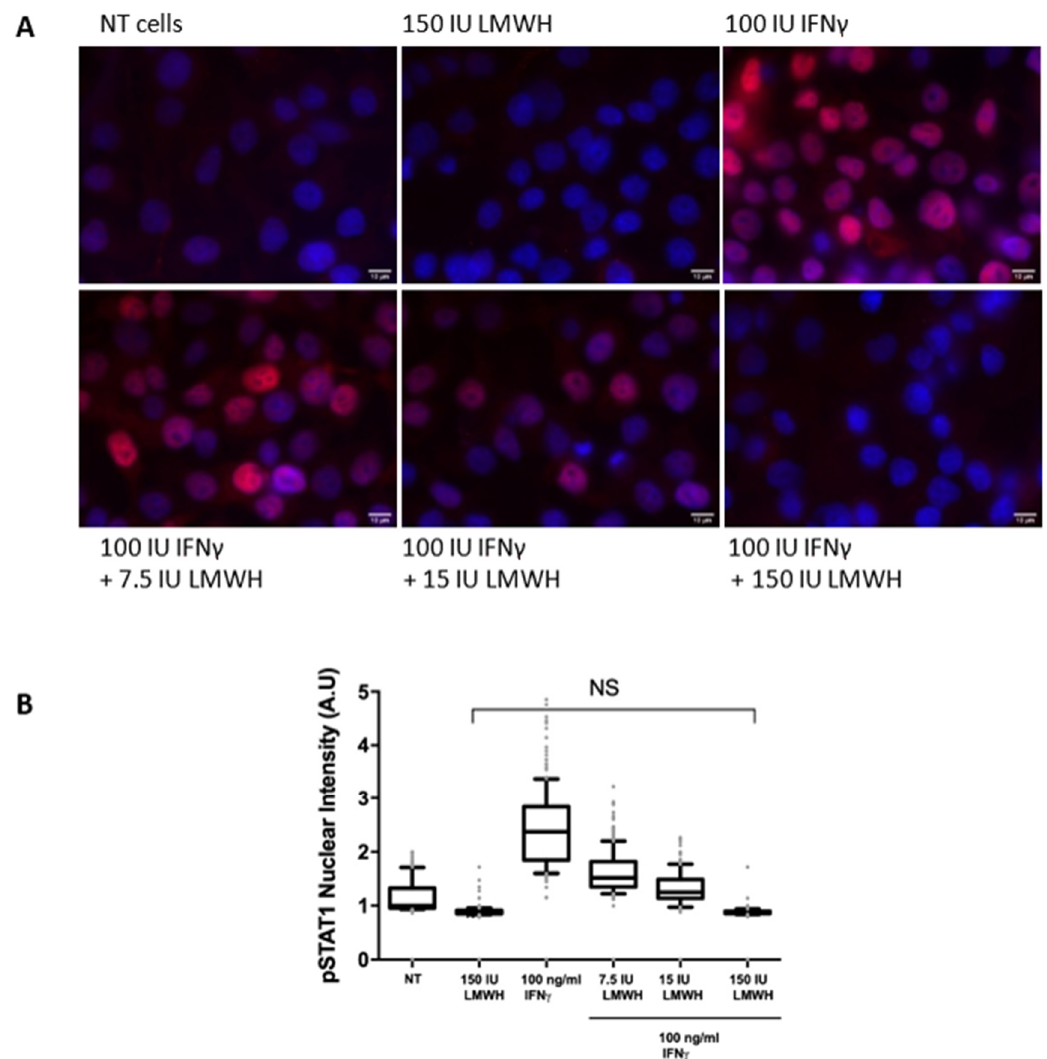
Figure 5. Translocation of the phosphorylated STAT1 into the cell nucleus. Translocation of the phosphorylated STAT1 into the cell nucleus. ( A ) WISH cells were treated with LMWH or IFN γ only, or with IFN γ after pretreatment with LMWH at the indicated concentrations, and fixed and stained with an antibody against pSTAT1 (Tyr701). The nuclei were counterstained with DAPI. Representative images are shown; scale bar, 10 µm; ( B ) Distribution of nuclear intensity of pSTAT1 (Tyr701) of individual nuclei from (A). Data are from 3 independent experiments ( n > 200 per condition per experiment); NS—non-significant (two-tailed unpaired Student’s t -test).